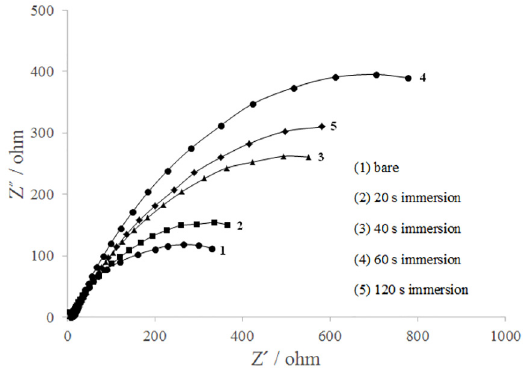
Figure 2. The Nyquist plots of cerium-coated steel in 3.5 wt% NaCl solution. Conversion coatings were obtained in cerium